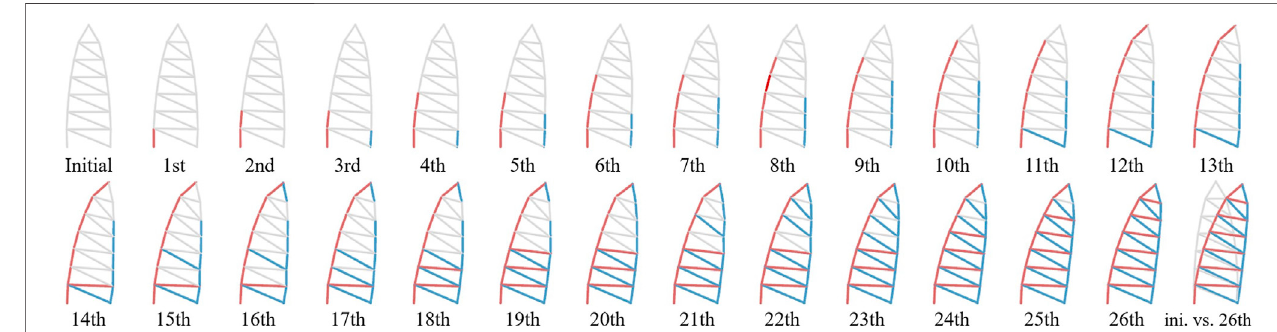
FIGURE 7 | Stepwise process of choice for the placement of 26 actuators by operator χ ( Figure 12 ).